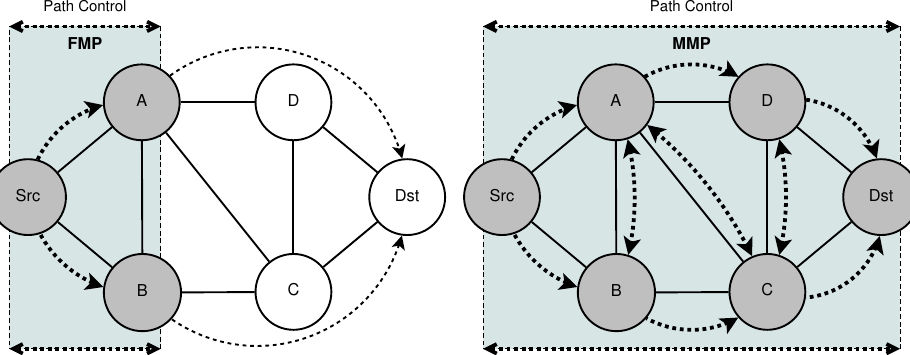
Figure 2. Source AS Src can choose a link between/among first hops to mitigate a link conges- tion/failure; however, FMP cannot choose a path after the first hops even if there are network hazards before the destination Dst . MMP can control all ASes between Src and Dst , allowing a path to be chosen by considering the link